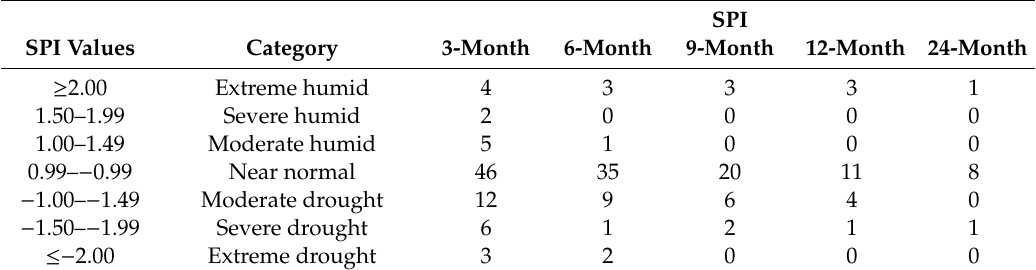
Table 5. Number of droughts, near normal and humid phases for selected SPI time scales.